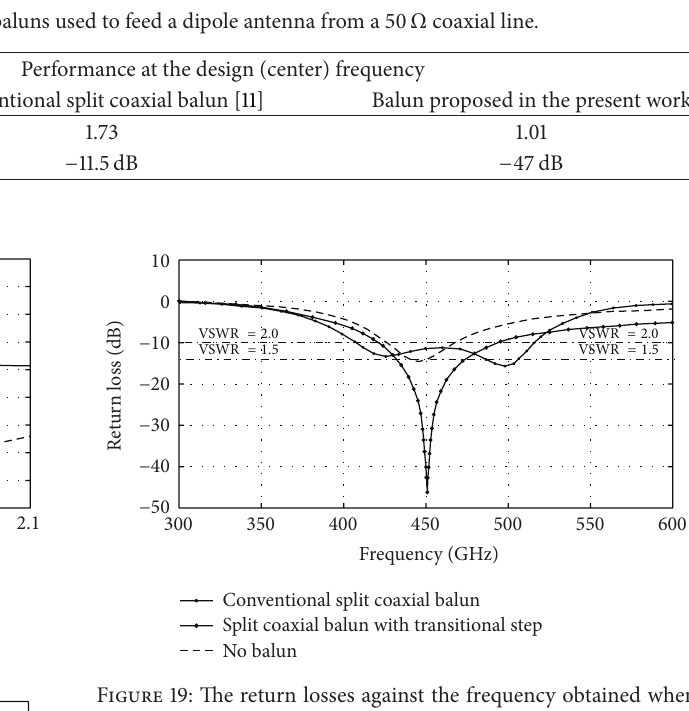
Figure 19: The return losses against the frequency obtained when feeding a strip dipole antenna with (i) a conventional split coaxial balun as designed in [11], (ii) a split balun with a step transition of the inner conductor as optimized in the present work, and (iii) a coaxial line (no balun is